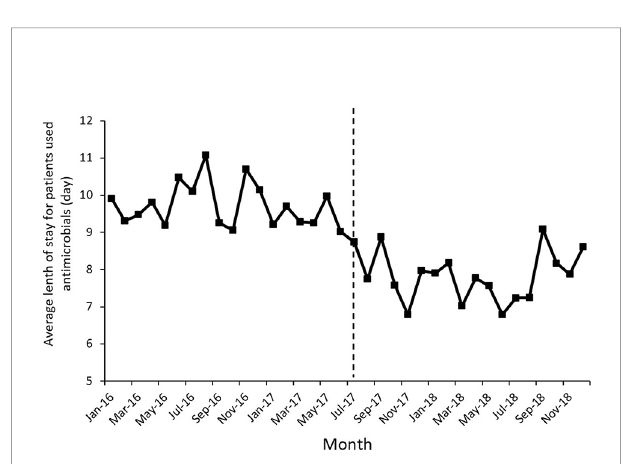
FIGURE 3 | The change of the average length of stay for patients used antimicrobial per month pre- and post-intervention. The vertical line separated two segments (before and after the MPL intervention).